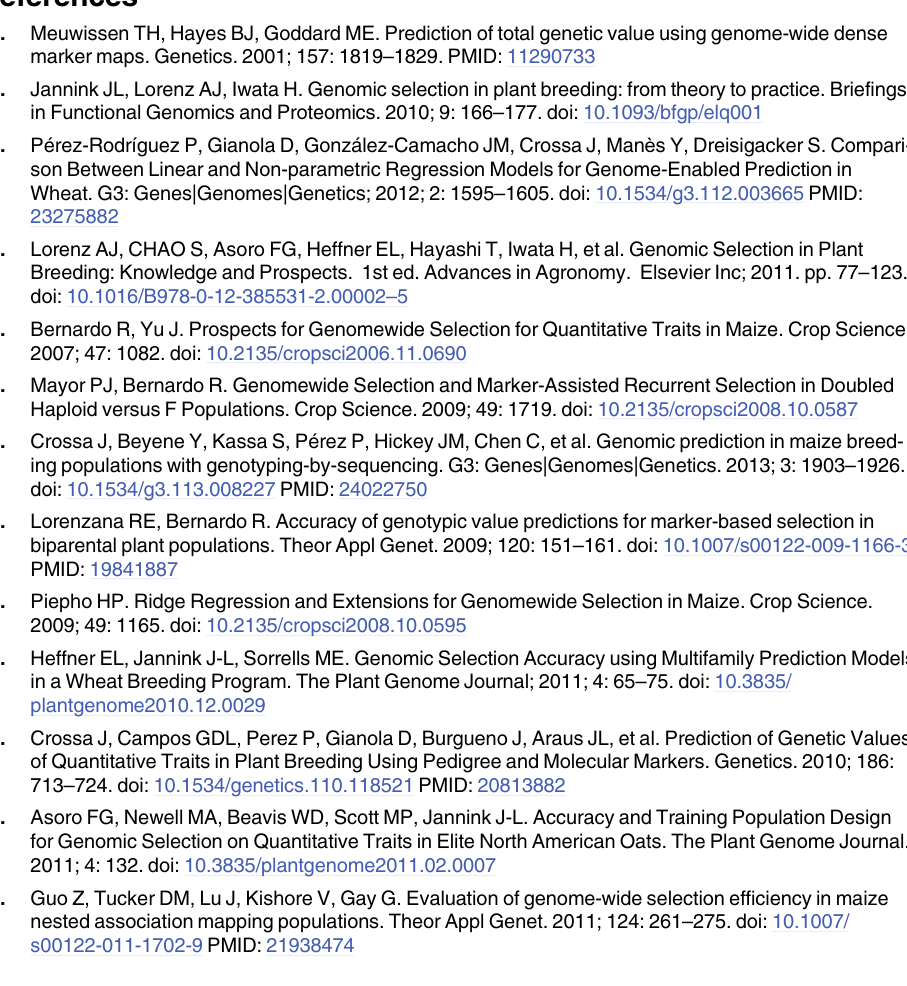
S6 Table. Least square means (LSMeans) for the third set of 840 cross validation experi- ments testing the significant difference between grouped effect of different scenarios for the sampling of training and validation